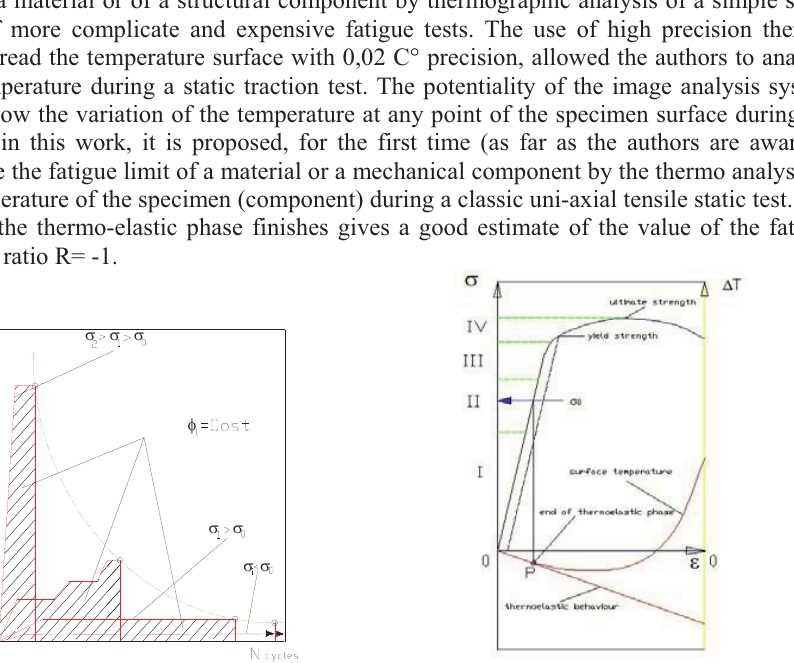
Fig1 . Parameter (cid:2) for different load ((cid:3) l